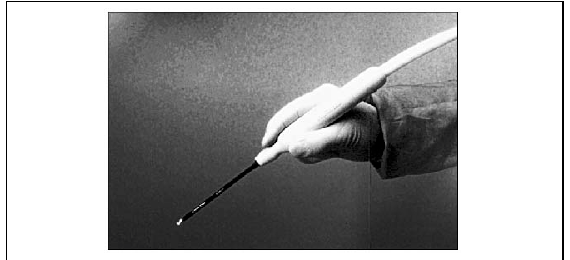
Fig. 2 – Foto do UltraCision ® dispositivo ultra-sônico projetado para cortar e coagular tecidos utilizados para tratamento intra- operatório da FAC.